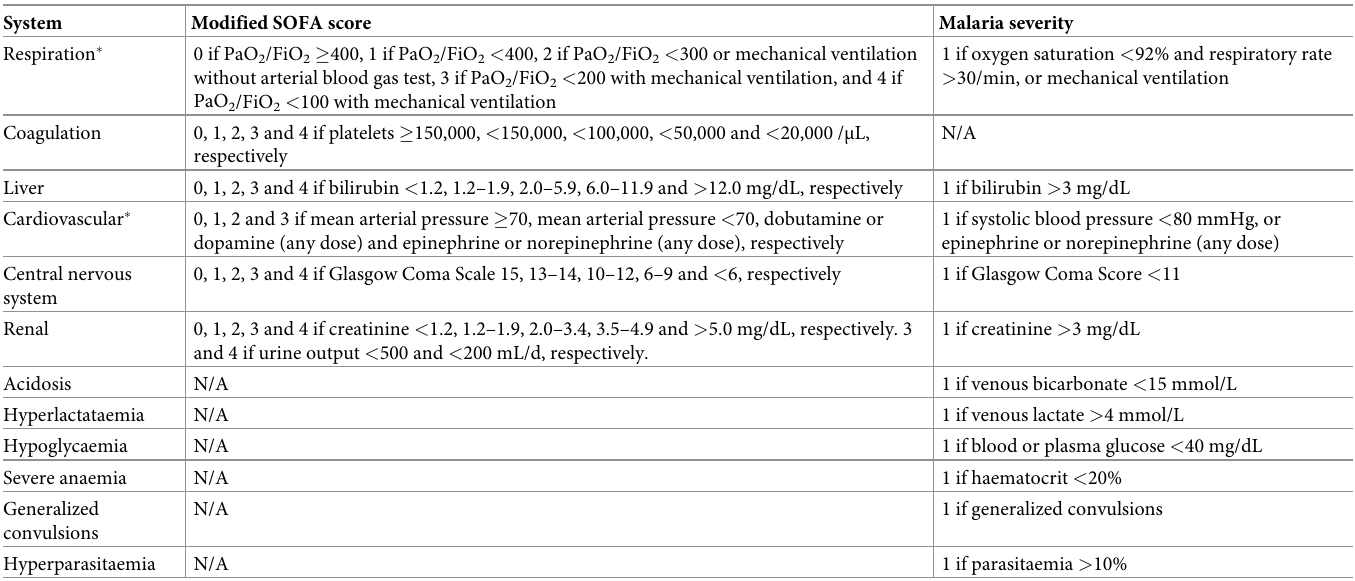
Table 1. Comparison between modified SOFA score and malaria